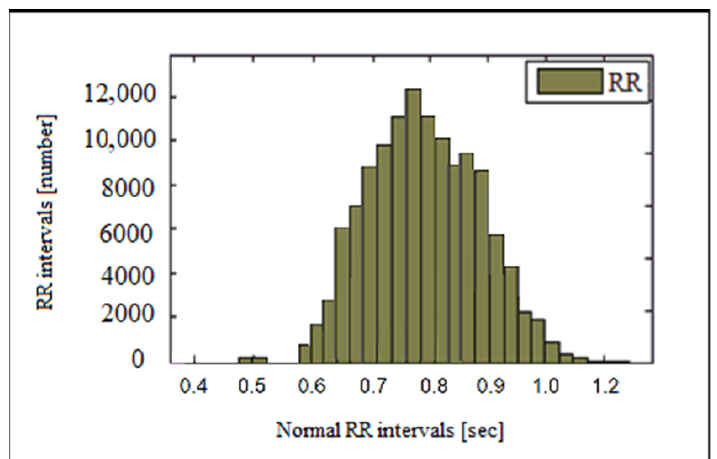
Figure 7. Histogram of a healthy individual.